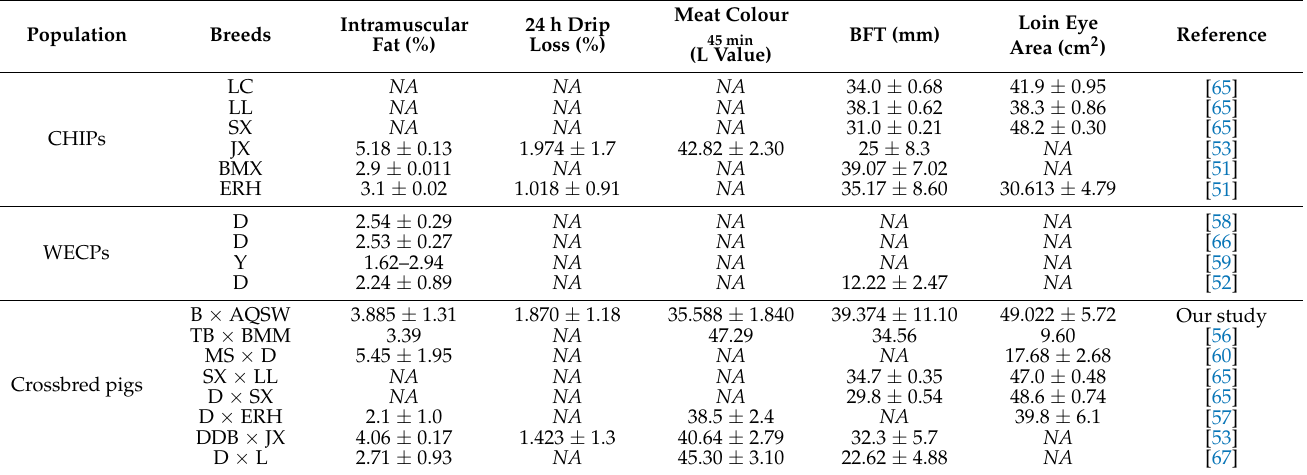
Table 3. Comparison of pork quality traits in multiple pig populations and